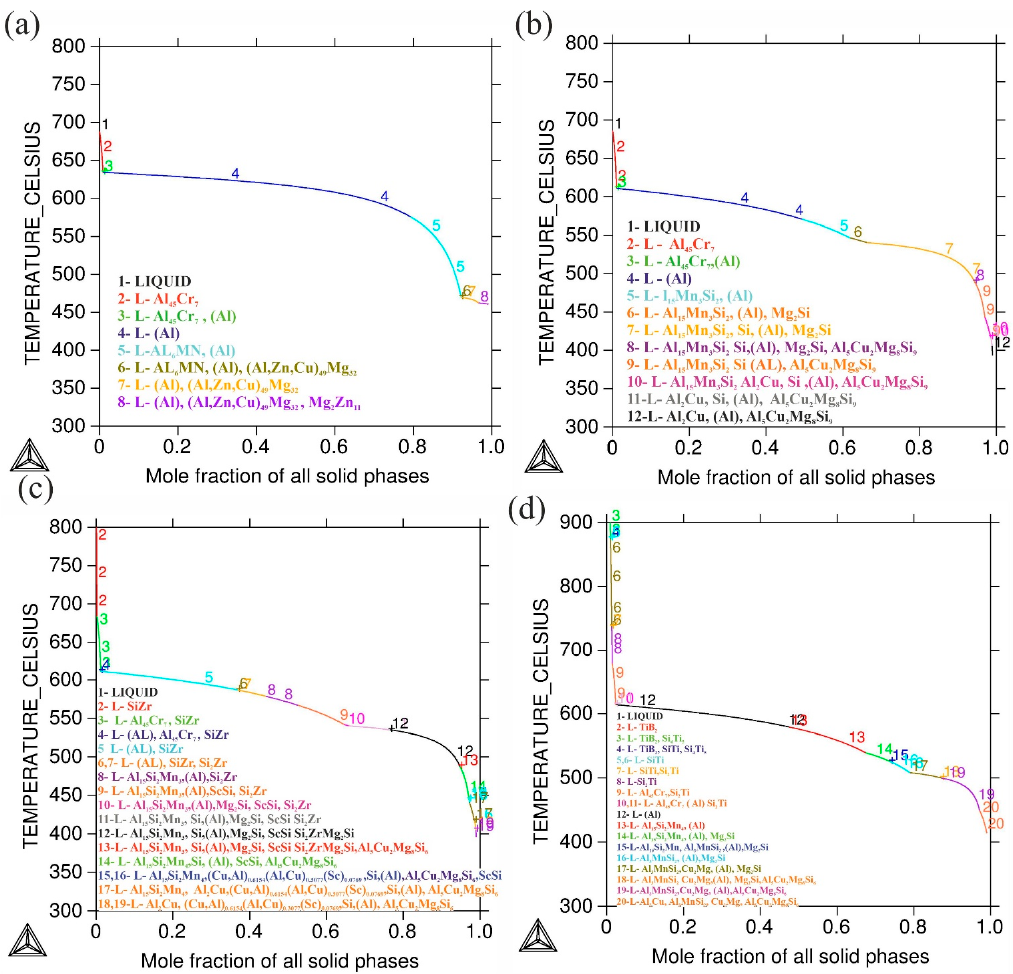
Figure 1. Thermo-Calc generated Scheil solidification curve with predicted phases for ( a ) 7075 alloy, ( b ) 7075-4%Si, ( c ) 7075-4%Si + ScZr, and ( d ) 7075-4%Si + TiB.